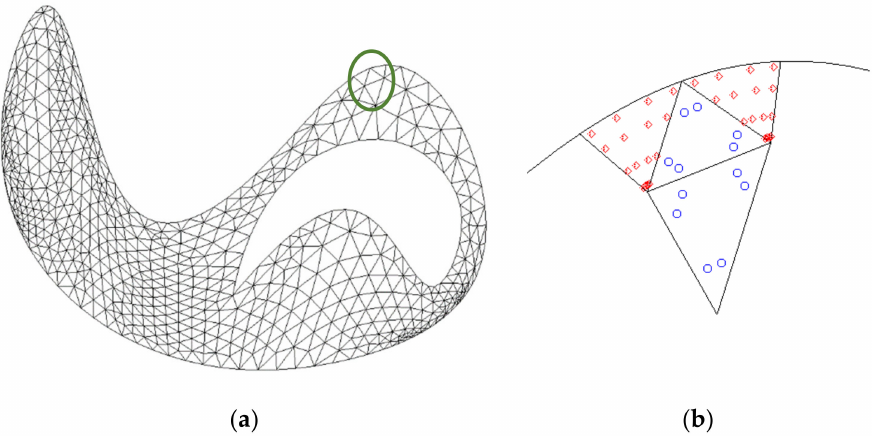
Figure 4. ( a ) Hybrid triangle meshes; ( b ) Gaussian quadrature points in boundary and inner